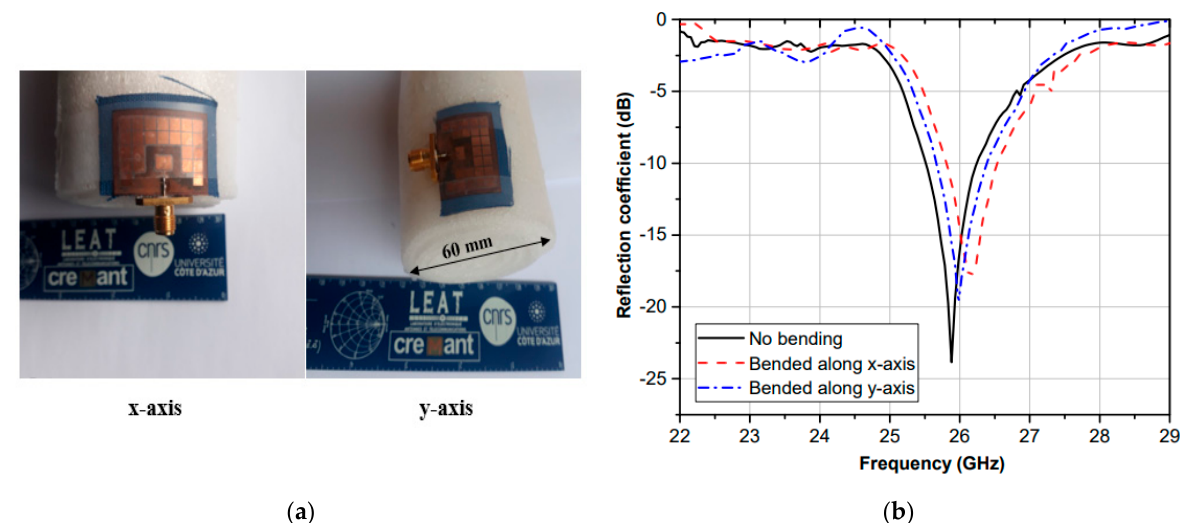
Figure 11. Performance of the proposed antenna when bent; ( a ) bending of the EBG textile antenna; ( b ) measured return loss S 11 .